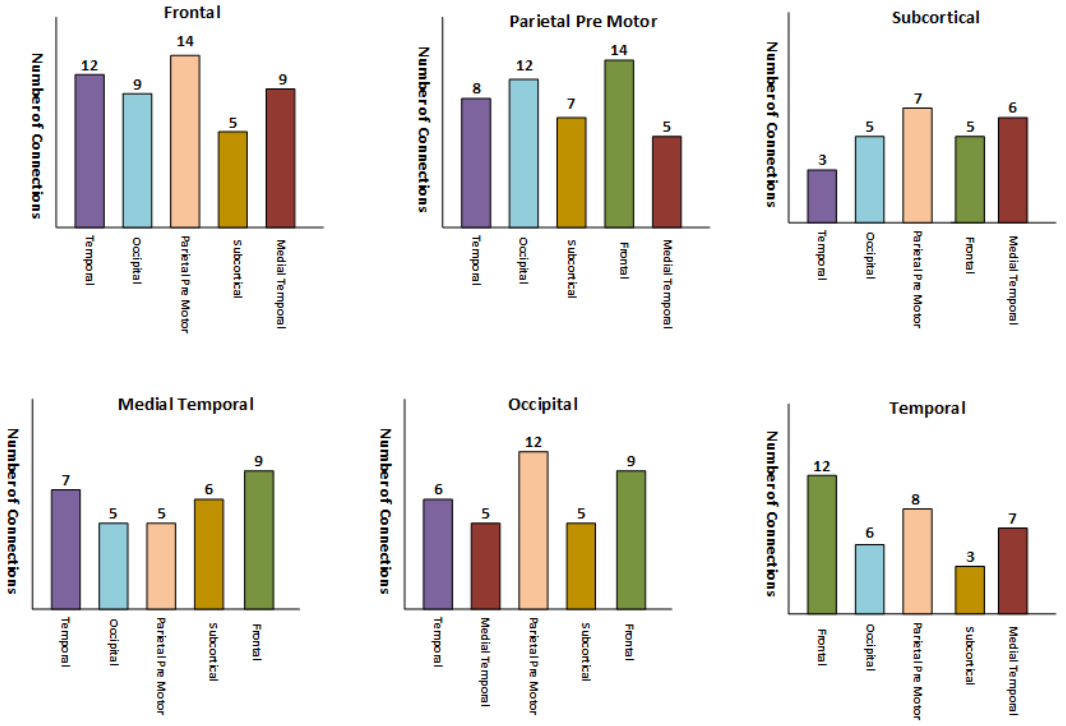
Figure 4. Brain’s Lobe wise connection statistics comparison